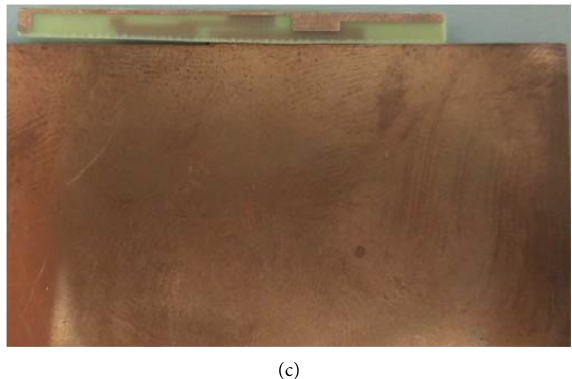
Figure 2: Prototype antenna: (a) full front view; (b) partial front view; (c) bottom view.